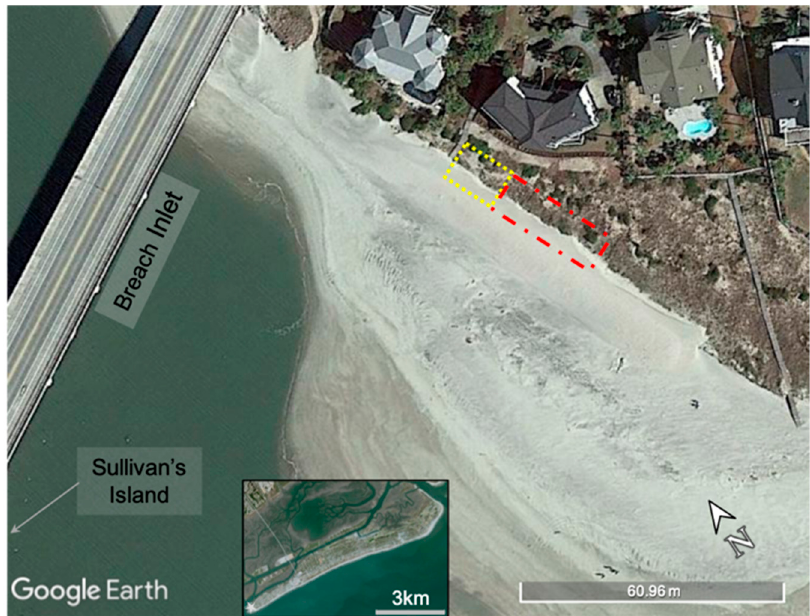
Figure 2. Aerial image showing the southwest tip of the Isle of Palms, SC. Yellow and red rectangles highlight the location of the natural and mechanical dunes, respectively. Inset shows the entire Isle of Palms where the star is the southwest tip of the island shown in the larger figure.